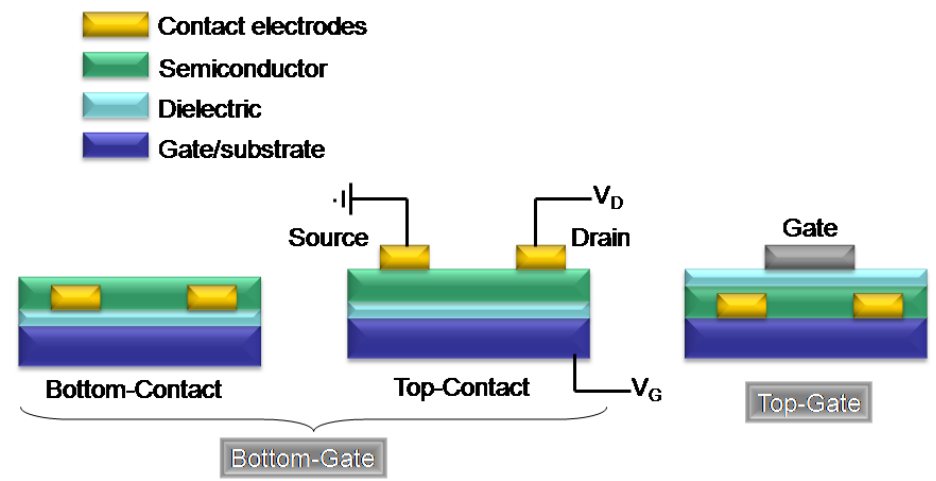
Figure 1. Various configurations of organic field-effect